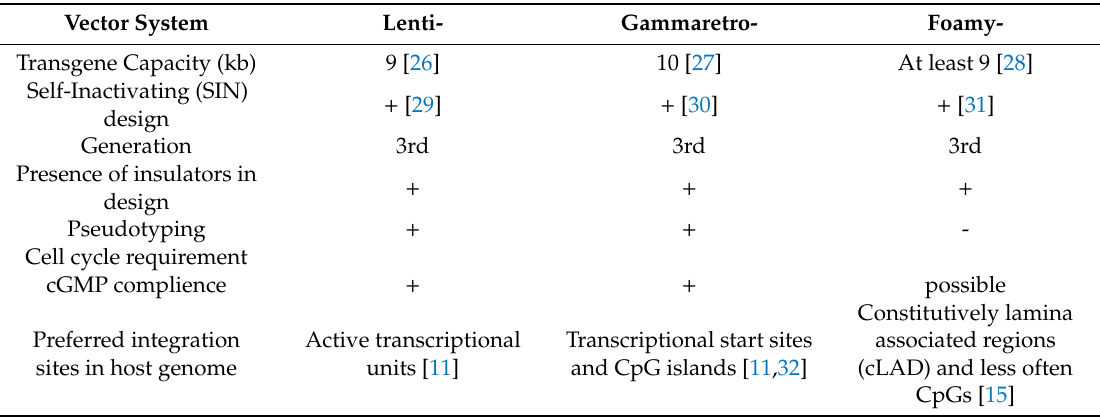
Table 1. Features of Retroviral gene delivery